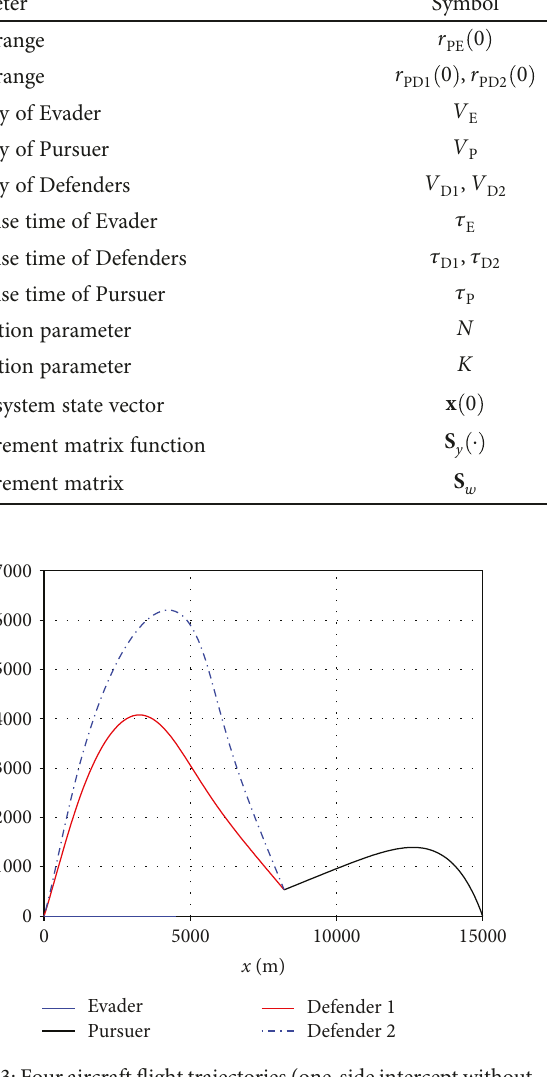
Figure 3: Four aircraft fl ight trajectories (one-side intercept without cooperation of Evader).